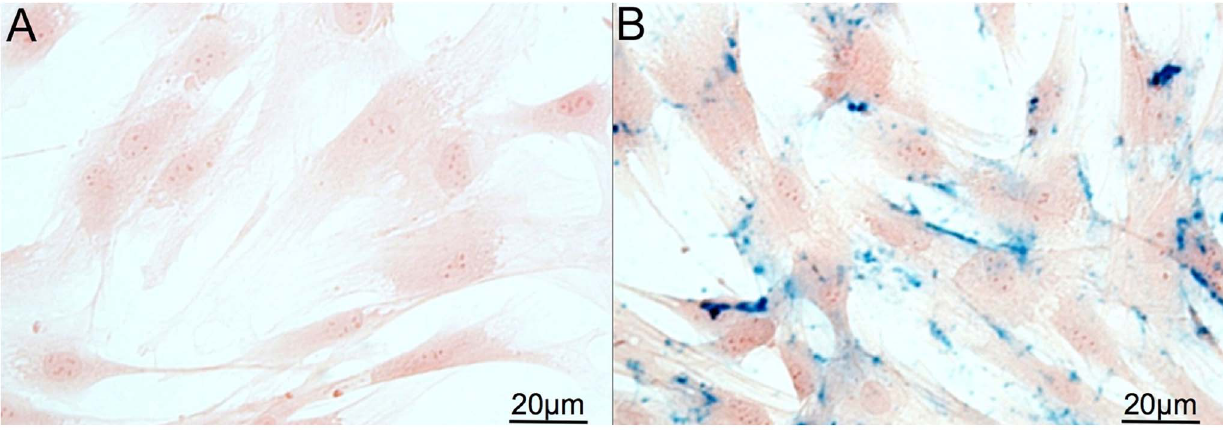
Figure 1. Demonstration of the VSOP uptake by the MSC. Micrographs of MSC after Prussian Blue staining after cultivation with (A) or without (B) iron oxide nanoparticles VSOP incubation (3 mM). The multiple blue dots in (B) represent VSOP particles in the cells.